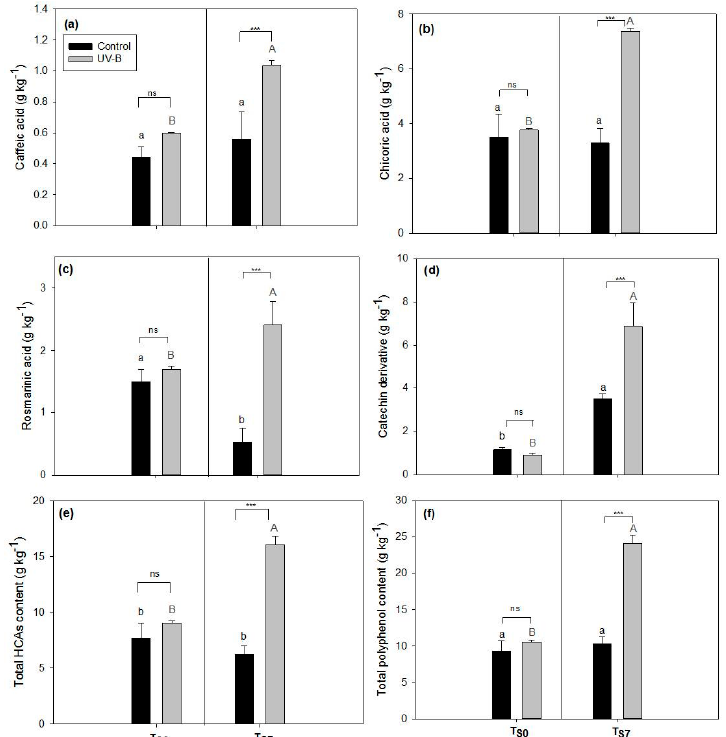
Figure 2. Polyphenolic content ( a to f , in g kg − 1 of dry weight) of leaves of O. basilicum plants cultivated under white light (control—black bars) and supplemental UV-B radiation (UV-B—gray bars) at the end of the light treatment (before storage, T S0 ) and after seven days of storage (T S7 ). Mean ± SD ( n = 3). ( a ) Caffeic acid content, ( b ) chlorogenic acid content, ( c ) rosmarinic acid content, ( d ) catechin derivative content, ( e ) total hydroxycinnamic acid derivatives content (HCAs), ( f ) total polyphenol content. Letters show the comparison between different storage times (T S0 or T S7 ) under the same light conditions (uppercase gray letters—UV-B treatment; lowercase black letters—control). Different letters indicate significant differences between the values ( p < 0.05), while asterisks show a significant difference between light treatments at the same time of storage (*** p ≤ 0.001); ns = not significant.